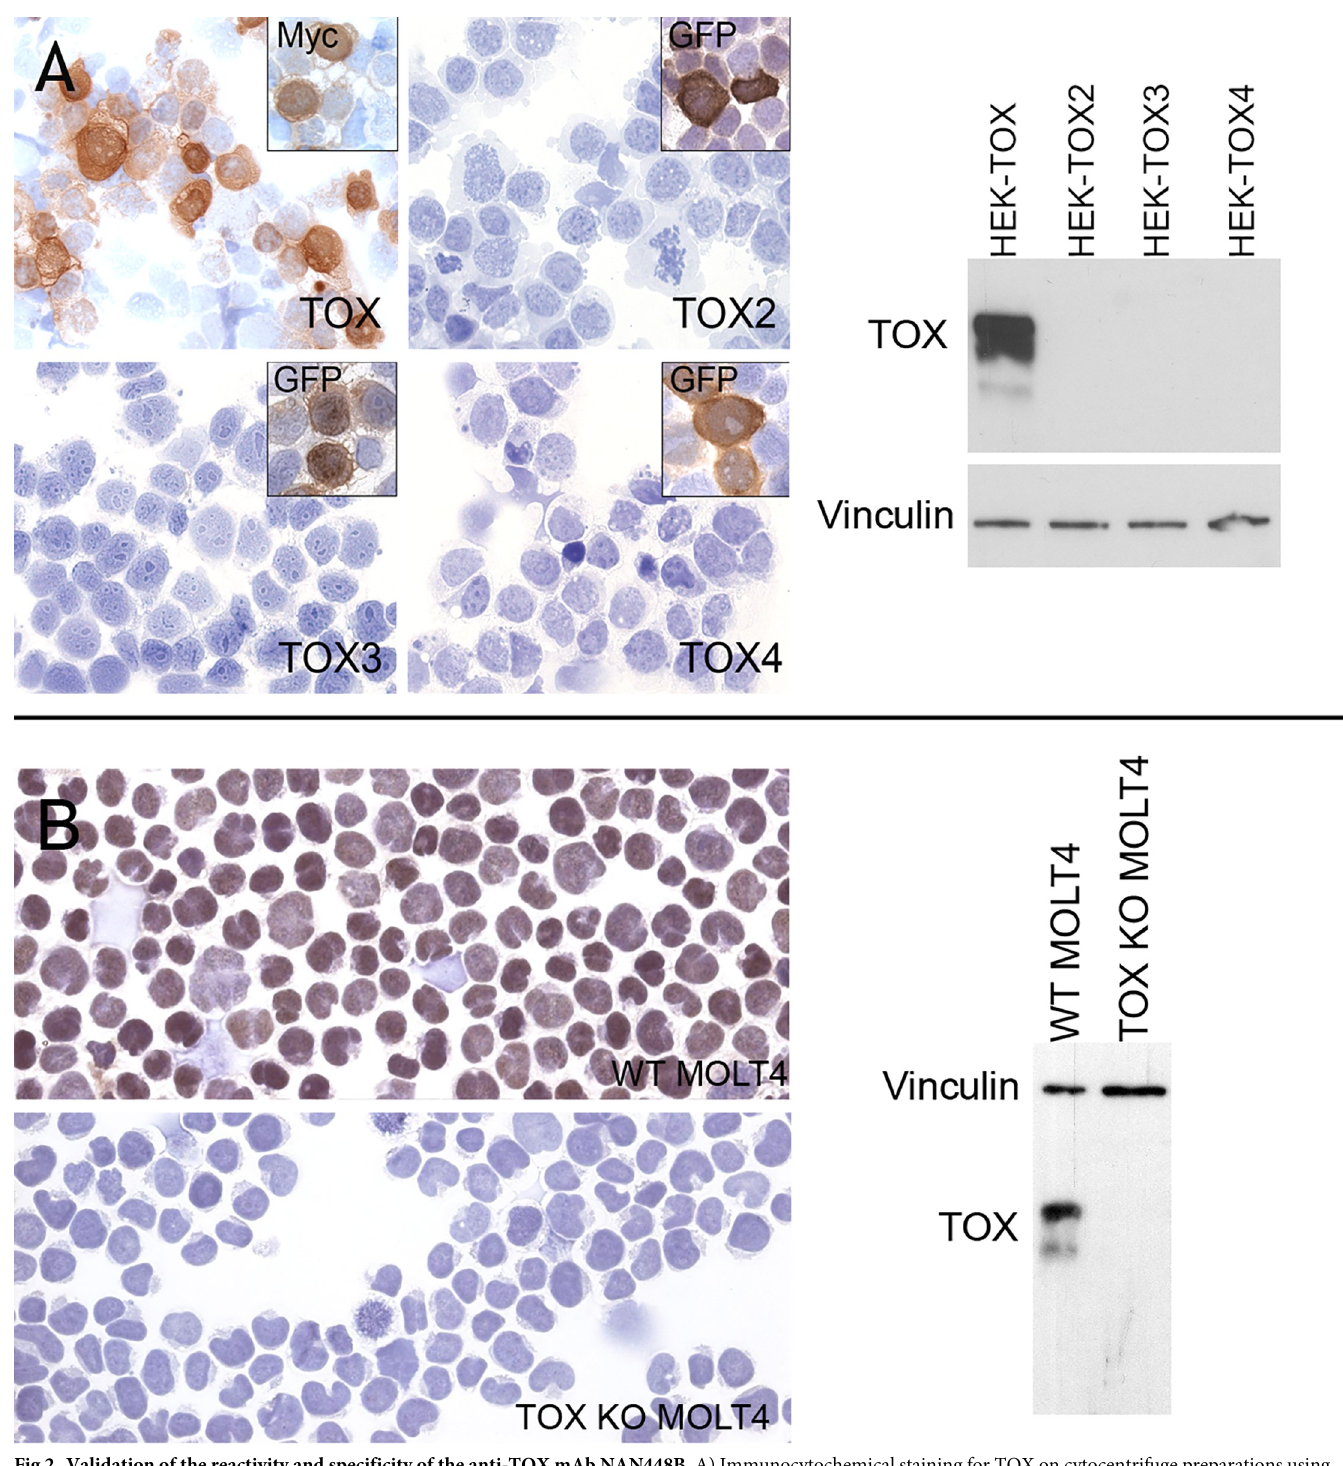
Fig 2. Validation of the reactivity and specificity of the anti-TOX mAb NAN448B. A) Immunocytochemical staining for TOX on cytocentrifuge preparations using NAN448B mAb. Staining of antibody NAN448B was observed in HEK-TOX-Myc transfectants but not in HEK-TOX2-GFP, HEK-TOX3-GFP and HEK-TOX4-GFP. The anti-Myc and anti-GFP mAbs were used to confirm transfection efficiency. Two bands of 63 kDa and 57kDa (weaker intensity) were detected by WB in HEK-TOX cell extracts while no expression was found in HEK-TOX2, HEK-TOX3 and HEK-TOX4. Anti-Vinculin antibody was used as loading control. B) Immunocytochemical staining for TOX on cytocentrifuge preparations of MOLT4 wild type (WT) and MOLT4 cell line after TOX gene inactivation using CRISPR-Cas9 technology (TOX KO MOLT4). Strong TOX staining was observed in the WT MOLT4 cytocentrifuge preparation while no staining was observed in the TOX MOLT4 KO cells. Two bands of